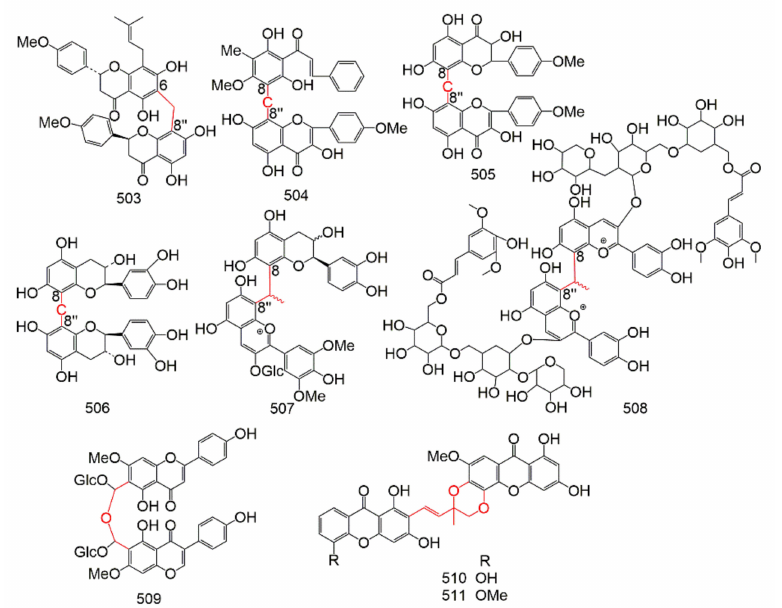
Figure 10. The structure of C-C-C and others type